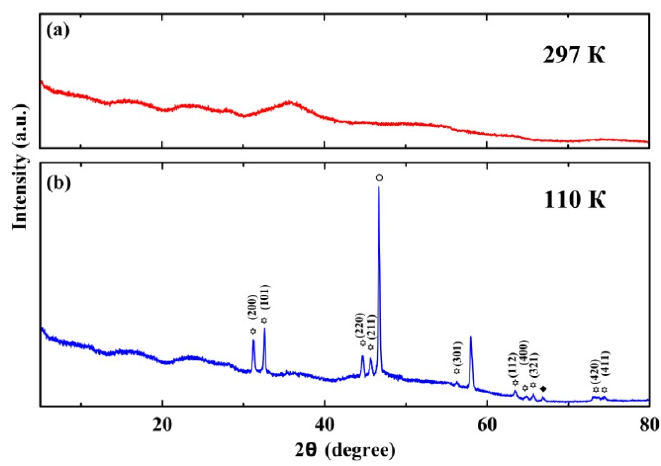
Figure 7. The X-ray patterns at 297 K ( a ) and 110 K ( b ). The peaks, which belong to the Sn-rich segregates, are marked with asterisks. The circle and diamond mark peaks which correspond to segregates with the structures of α -Ga and λ -Ga, respectively.